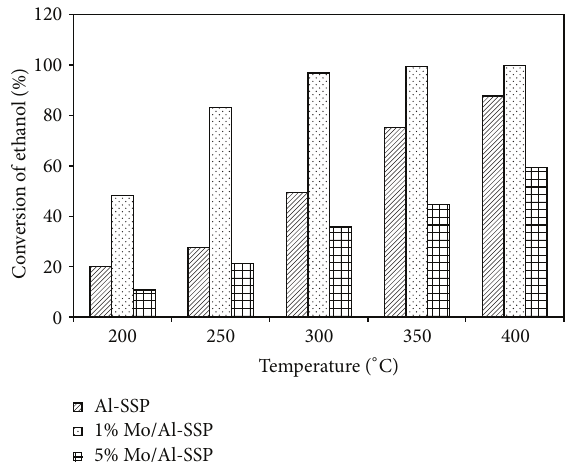
Figure 7: Ethanol conversion at different temperatures of all catalysts.